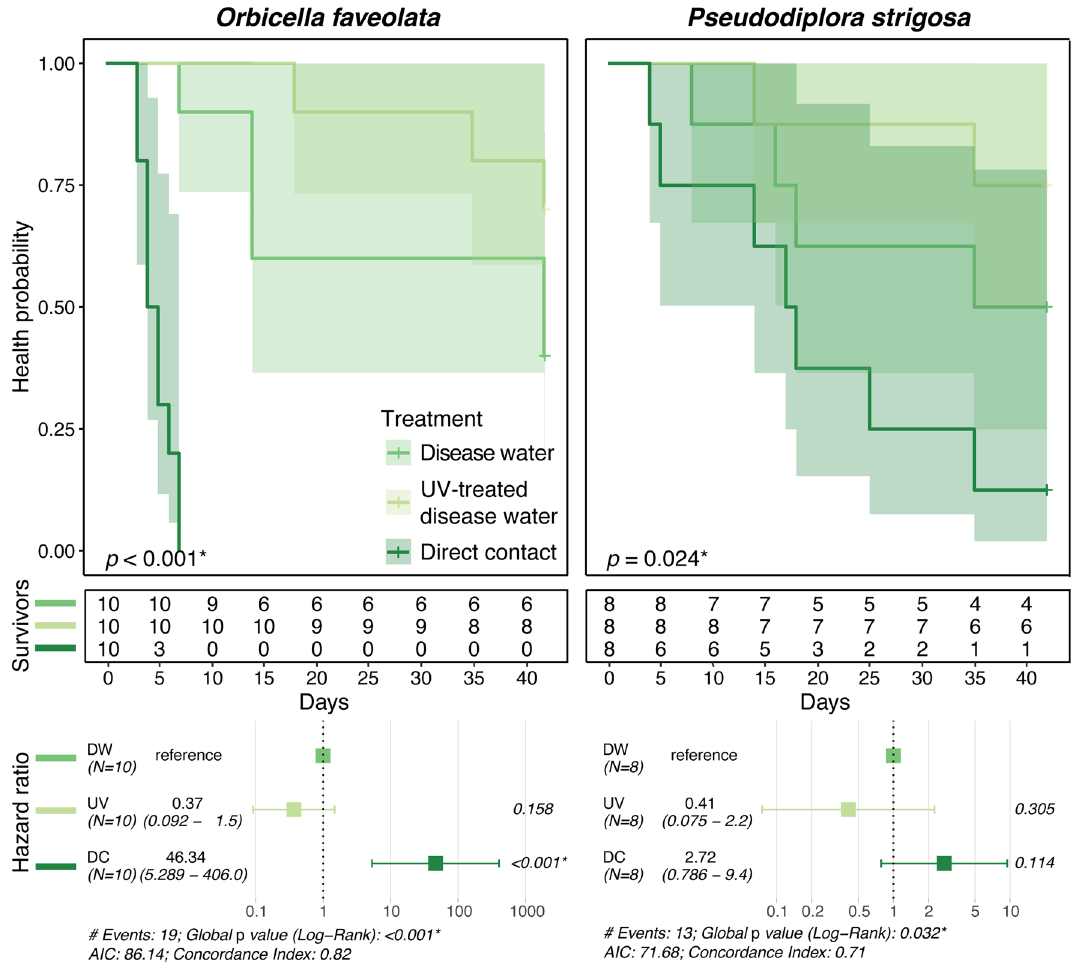
Figure 5. UV experiment survivorship curves. Mean time to initial observations of SCTLD lesions and transmission rates (proportion of individuals exhibiting lesions), with survivorship tables and hazard ratio tests of infection risk between treatments. Colors denote treatments, shaded areas denote 95% CI, and test statistics reflect the results of fit proportional hazards regression models for each species. Treatment abbreviations are as follows: disease water (DW), UV-treated disease water (UV), diseased coral direct contact (DC), and healthy water (HW).